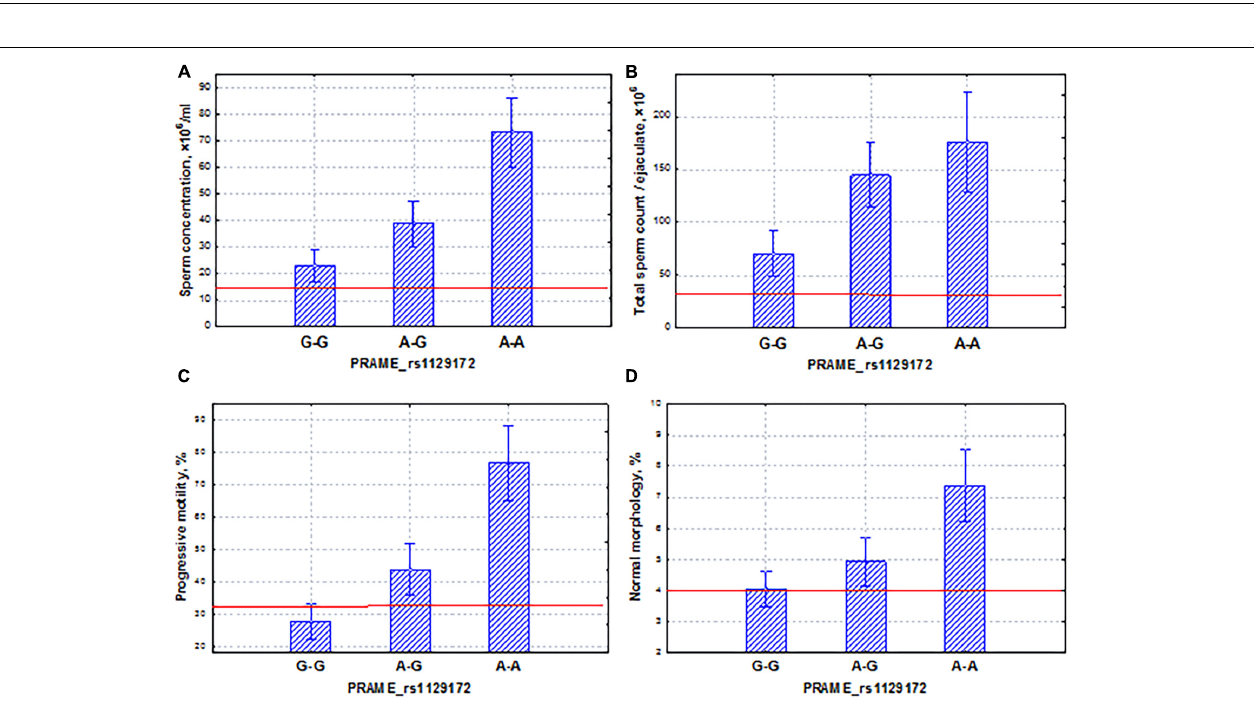
FIGURE 11 | Coordinated allelic effects of the SNP marker rs278981 of the RBM47 gene on semen quality parameters. (A) Sperm concentration, (B) total sperm count, and (C) proportion of motile, and (D) morphologically normal sperm. All the allelic differences were highly significant ( p < 0.005). The red lines indicate the WHO reference limits for different normal semen parameters [World Health Organization (WHO), 2010].